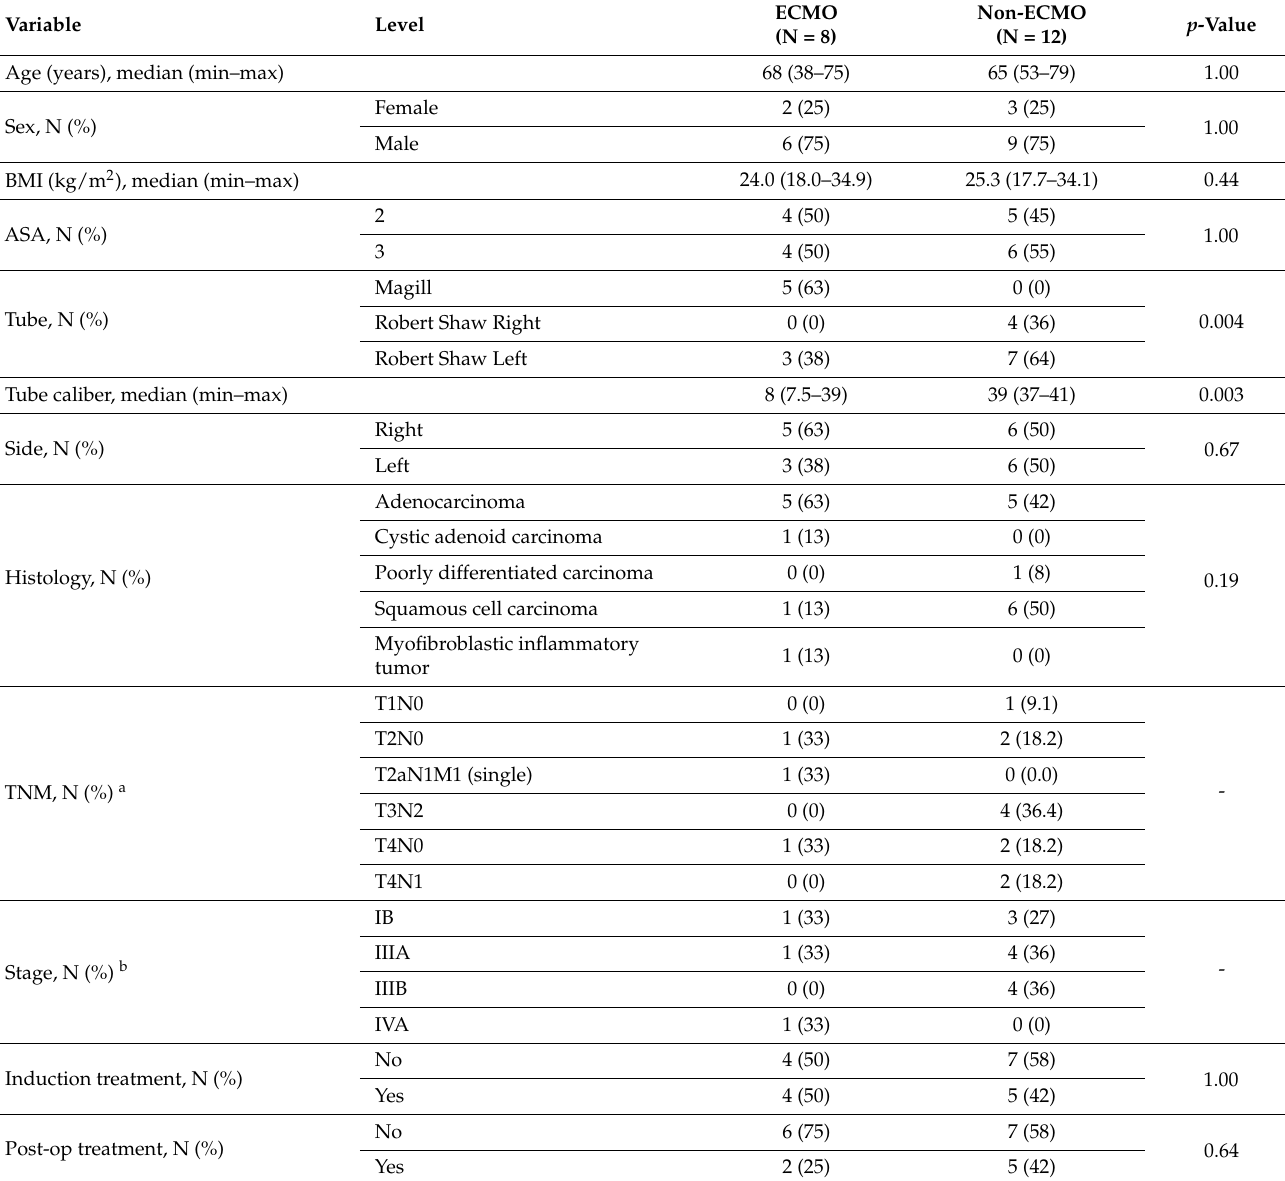
Table 1. Distribution of demographic and clinical variables among patients with and without intraoperative ECMO (N =